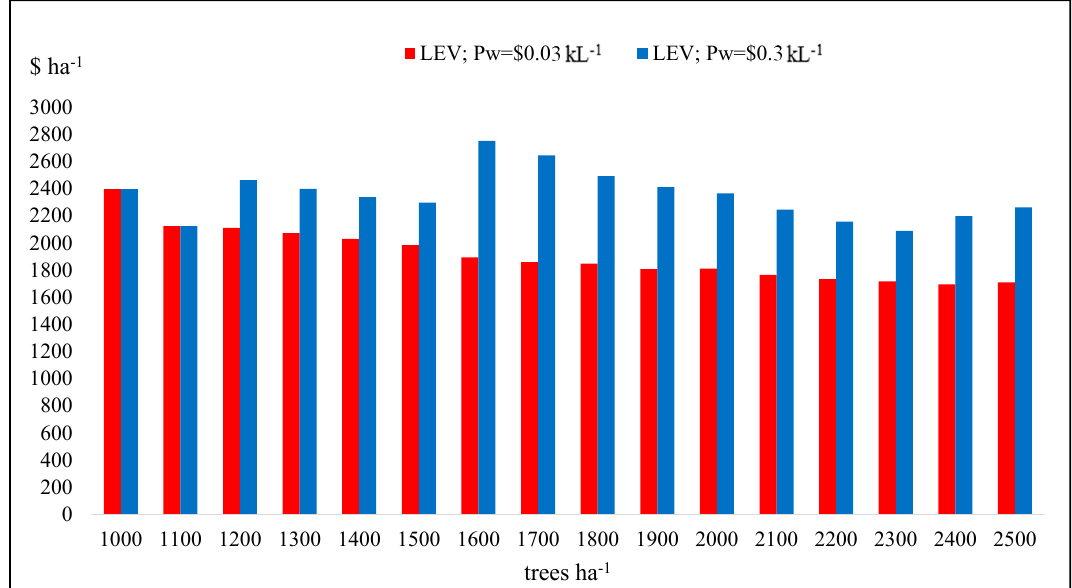
Figure 2. Variation of water yield ( ∆ W ) for different tree planting densities (TPD).